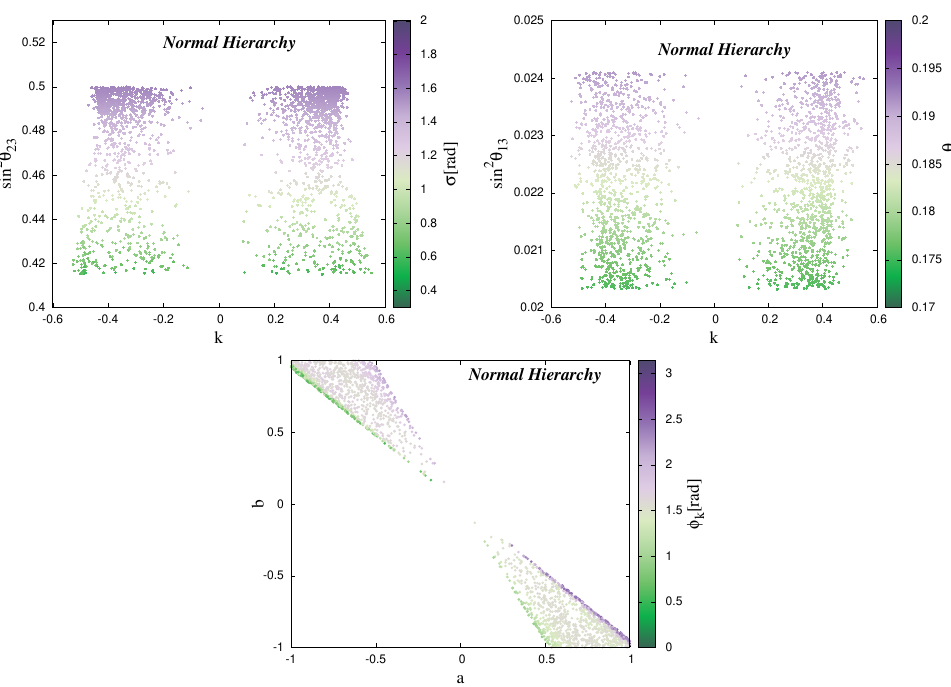
Figure 1 . The allowed points of the trimaximal mixing parameters σ (top left panel) and θ (top right panel) projected on the planes (cid:0) sin 2 θ shows the allowed points in the parameter space of ( a , b ) with the color code indicating the phase φ are not allowed which implies that the present model admits only the CP violating δ CP values of δ CP